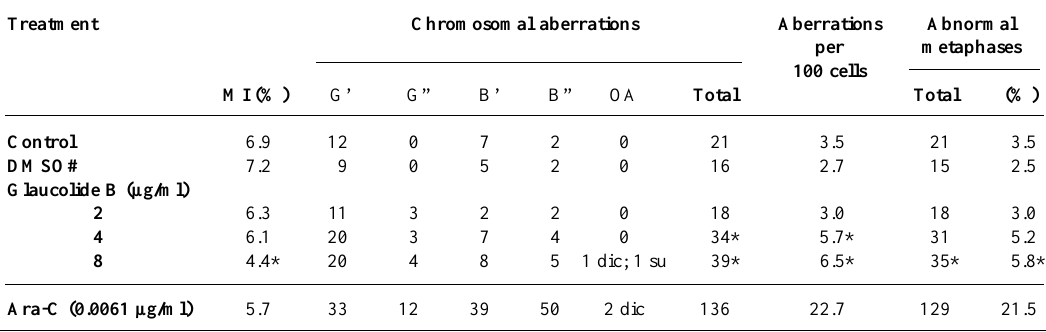
Table I - The mitotic index (MI) and the number of chromosomal aberrations and abnormal metaphases in human cultured lymphocytes treated with glaucolide B. Treatment